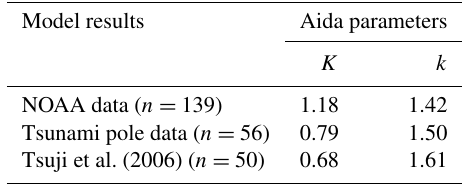
Table 4. The validation results of the simulation using Aida param- eters for scenario no. 211.